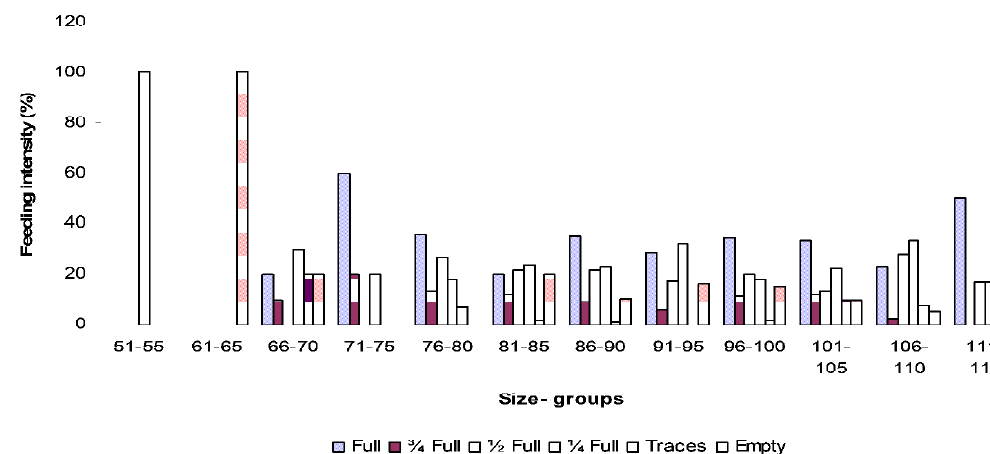
Fig. 11. Feeding intensity in different size-groups of females of S. melantho